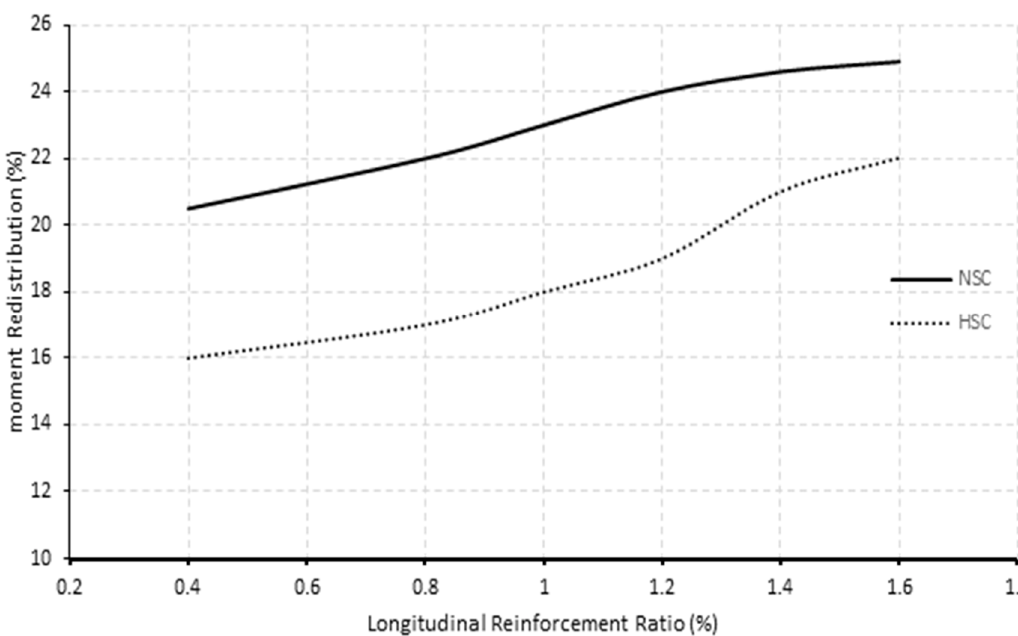
Figure 17. The moment redistribution and longitudinal ratio relationship for normal (40 MPa) and high (80 MPa) concrete strength beam specimens.